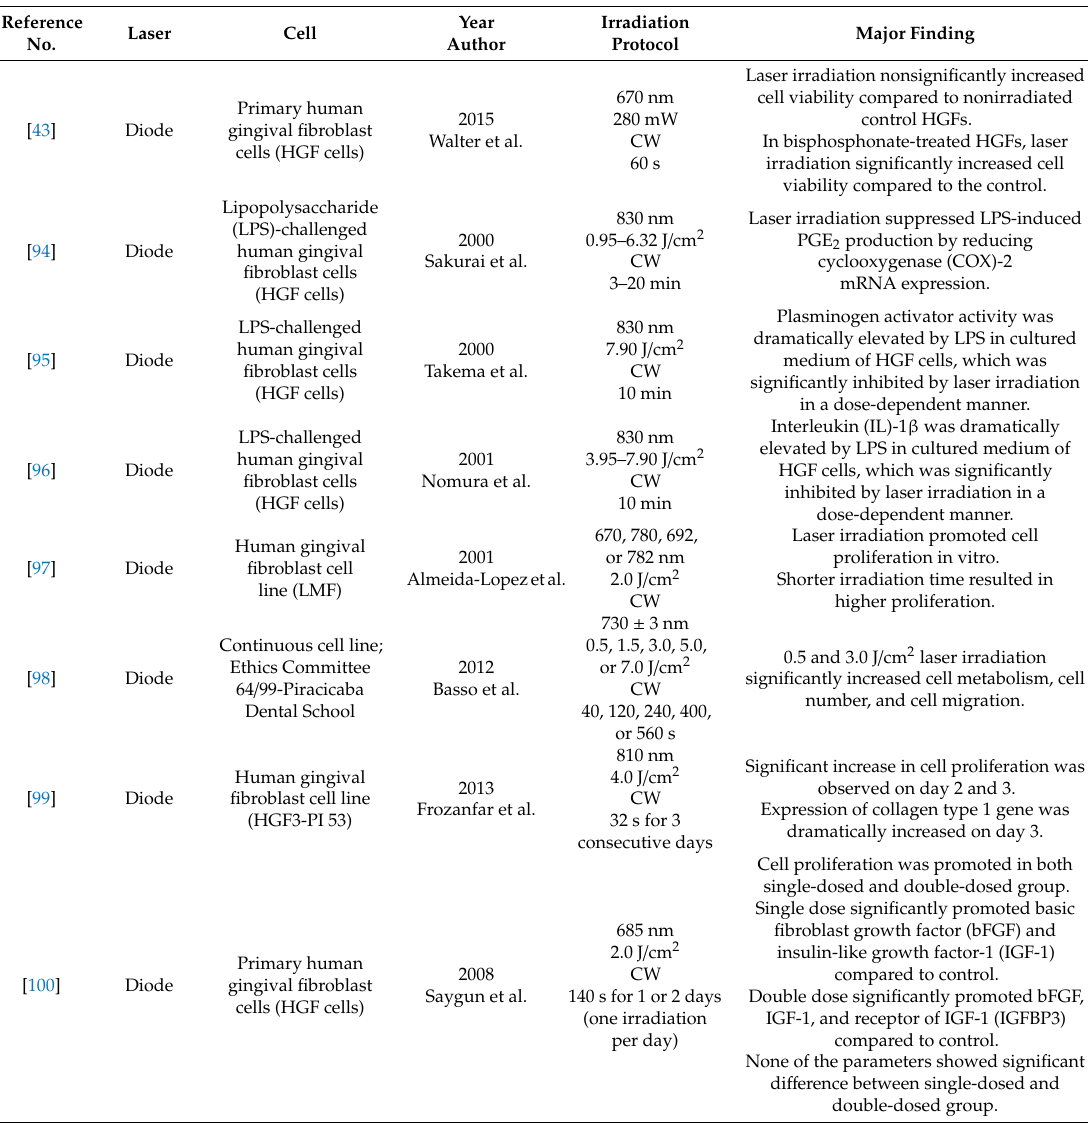
Table 2. Summary of the e ff ects of laser irradiation on